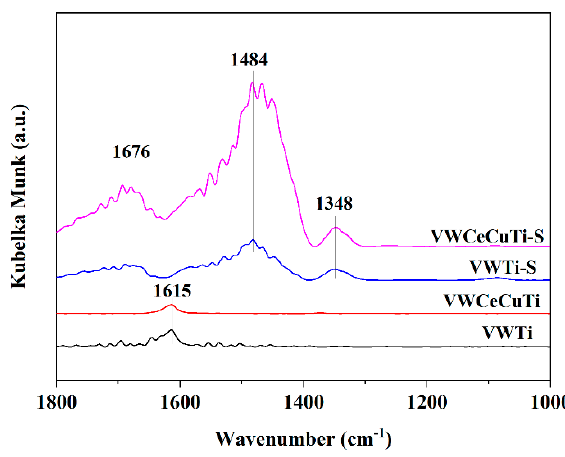
Figure 7. In situ DRIFT spectra of NO adsorption over fresh and S-poisoned samples at 250